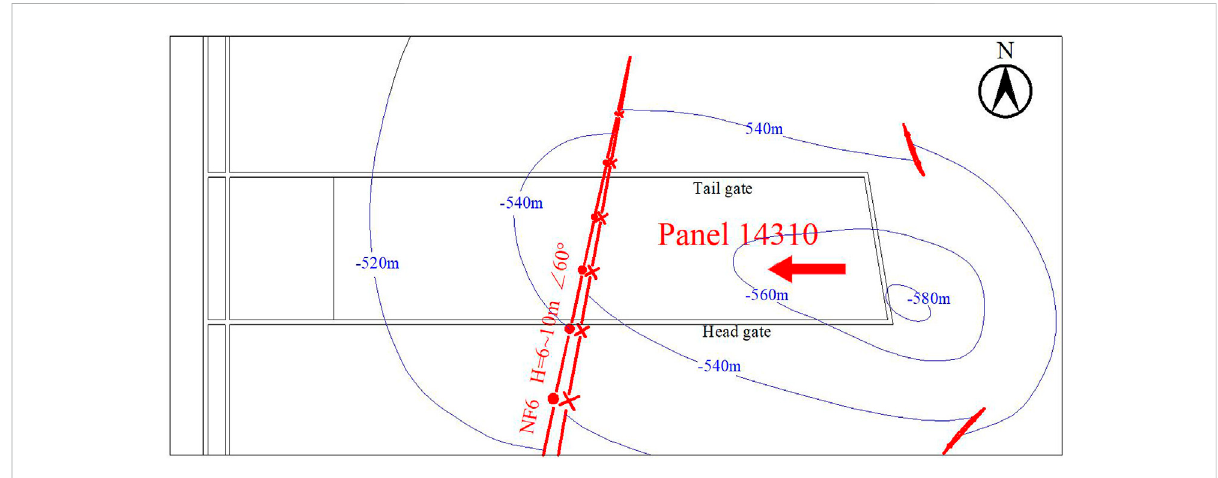
FIGURE 1 Layout of panel 14310 in Dongtan Coal